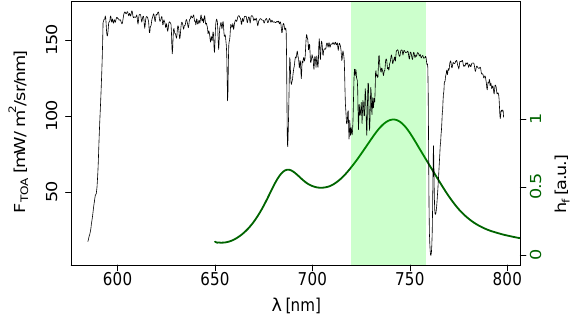
Figure 1. Sample GOME-2 spectrum in band 4. The spectral win- dow that we use for SIF retrievals (720–758nm) is marked in green. The reference fluorescence emission spectrum is depicted in